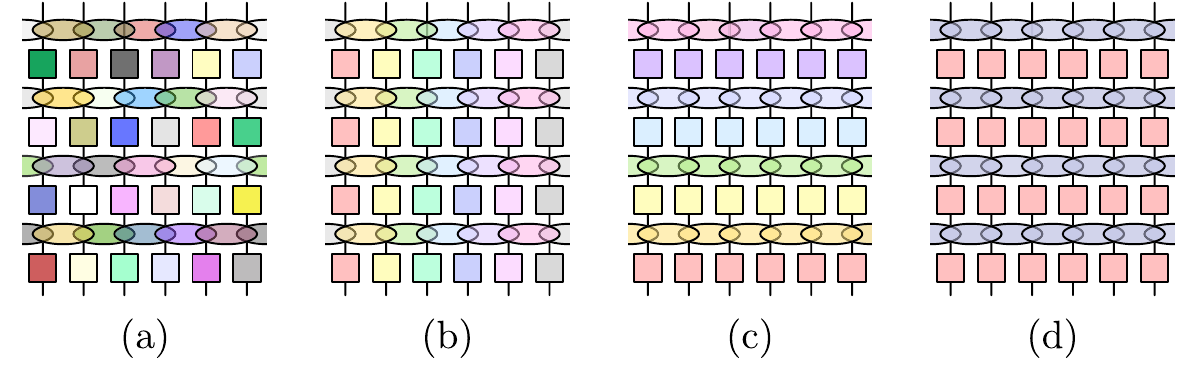
Fig.1|IllustrationsofthedifferenttypesofRUCfortherandomphasemodel.a TemporallyandspatiallyrandomRPM; b Floquet(andspatiallyrandom)RPM; c TI(and temporally random) RPM, and d TI Floquet RPM. For each case, gates of the same colors are identical.